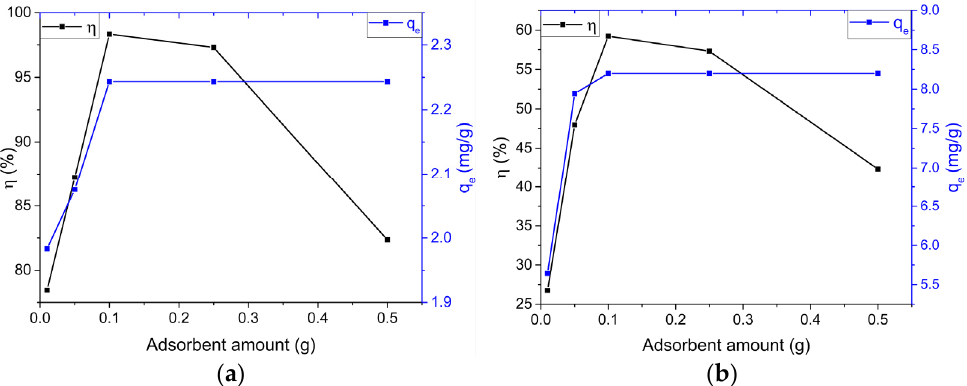
Figure 4. Effect of adsorbent amount on removal efficiency and maximum adsorbed amount by HCWS3; MB ( a ) and PRM ( b ). The black and blue lines represent the removal efficiency ( η ) and the adsorption capacity ( q e ), respectively.